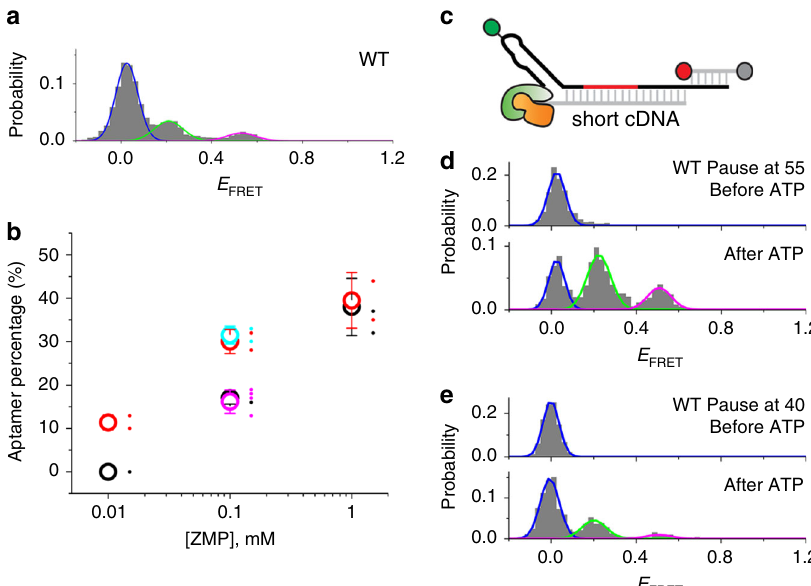
Fig. 4 The effect of slower unwinding speed and arti fi cial pausing on riboswitch folding. a VF histograms for WT ZTP riboswitch unwound by PcrA-X in the presence of 0.1 mM ZMP are shown with Gaussian fi ts to heteroduplex (blue), terminator (green), and aptamer (magenta) populations. b The percentage of aptamer-containing conformation obtained by VF with Rep-X (black) and PcrA-X (red) are shown in the presence of 0.01 to 1 mM ZMP. The percentage of aptamer-containing conformation obtained by VF for pause mimics at positions 40 and 55 (magenta and cyan, respectively) are shown. All values are mean ± s.d. shown as large open circles with n = 2 – 4 independent experiments shown as small circles and offset for clarity. c Cartoon depicting the pause mimic complex at position 54, in which a cDNA is hybridized only to nt 55 – 94 of the WT ZTP riboswitch. Addition of ATP initiates unwinding starting from nt 55 in this complex. d E FRET histograms of the cDNA:WT heteroduplexes mimicking a pause at position 55 before (top) and after (bottom) addition of ATP in the presence of 0.1 mM ZMP, as measured by VF with Rep-X. e E FRET histograms of the pause-mimicking heteroduplexes at position 40 before (top) and after (bottom) addition of ATP in the presence of 0.1 mM ZMP, as measured by VF with